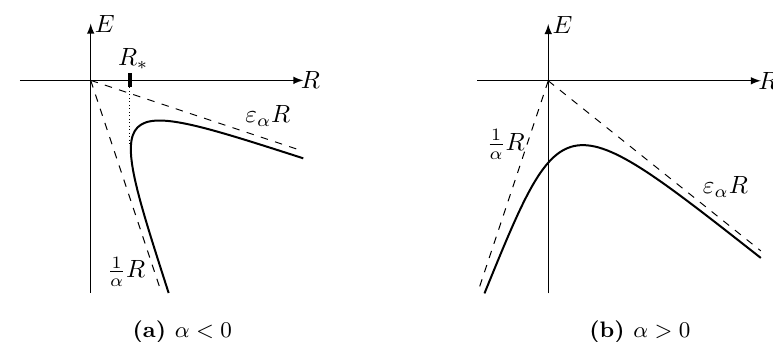
Figure 2. Finite-size ground state energy of the TTbar deformed theory. (a) α < 0 . The graph E α ( R ) shows the “turning point” at some finite R ∗ , which signals the Hagedorn transition. (b) α > 0 . E α ( R ) shows no singularity at R = 0